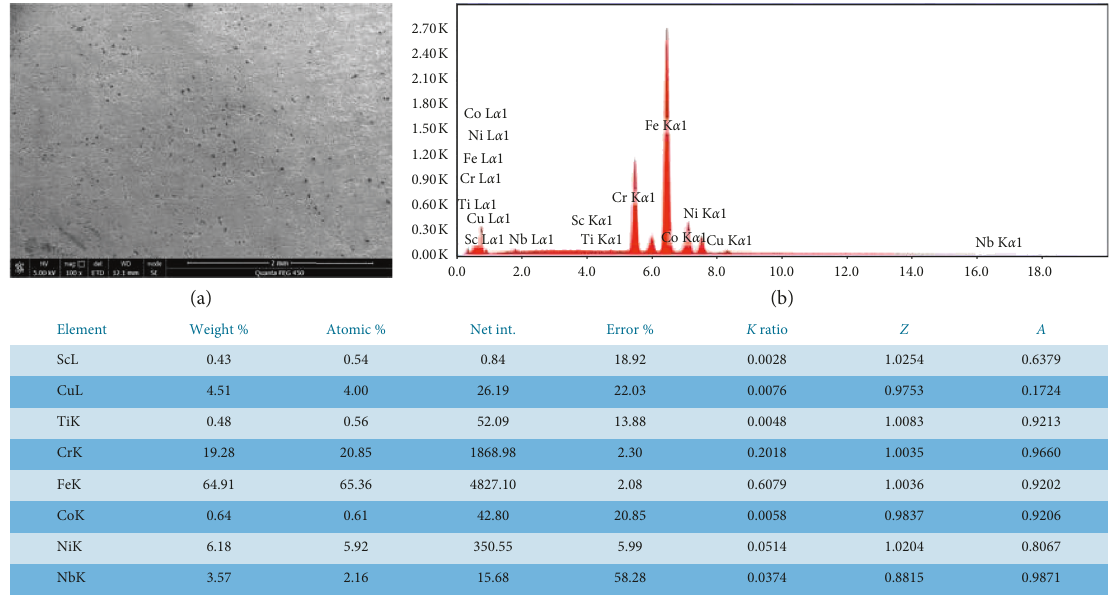
Figure 4: Microstructure (a) and the EDX analysis (b) of Inconel 706. Table 2: Process parameters used during the EDM process.